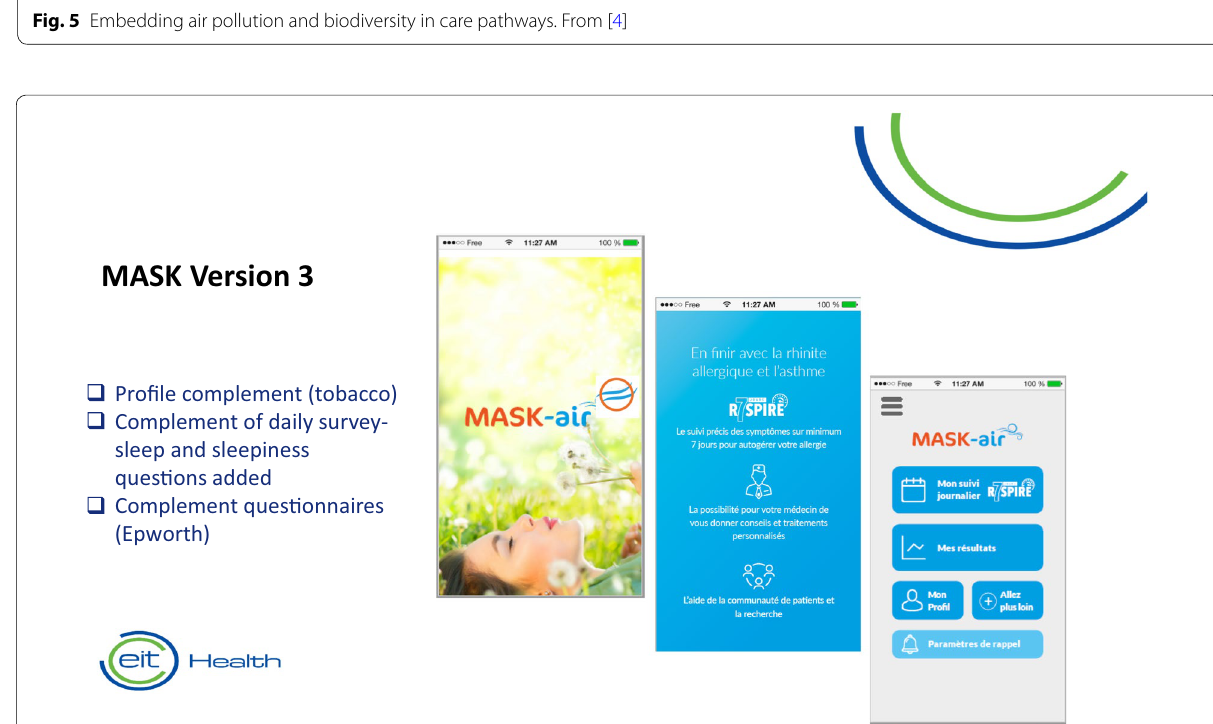
Fig. 6 From The Allergy Diary to